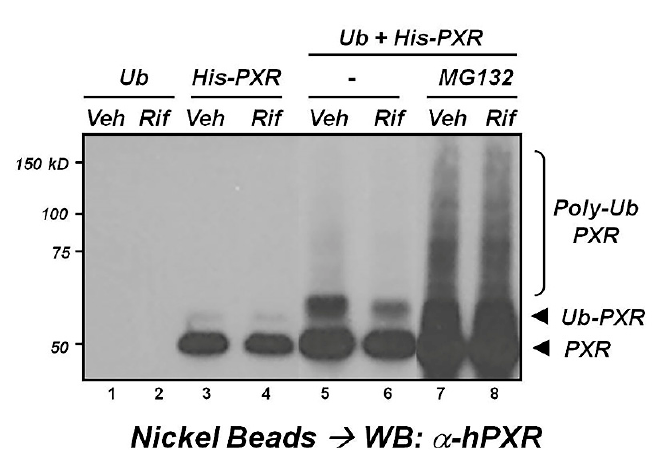
Figure 2. PXR is ubiquitinated in cells. The plasmid encoding 6x-Histidine-tagged PXR (His-PXR) protein was transfected alone or together with an expression vector encoding ubiquitin (Ub) into HeLa cells. Twenty-four (24) hours post-transfection, cells were treated for an additional 24 h (VEH = 0.1% DMSO, Rif = 10 µ M, MG132 = 25 µ M). Total cell extract was subjected to purification using nickel-linked agarose beads, followed by SDS-PAGE and subsequent Western blotting with anti-PXR antibodies (Santa